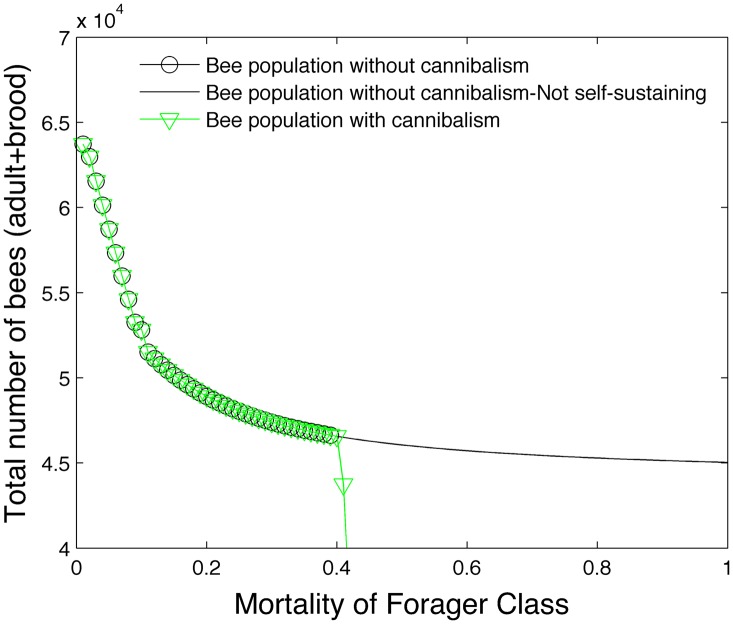
Effect of cannibalism on bee population.